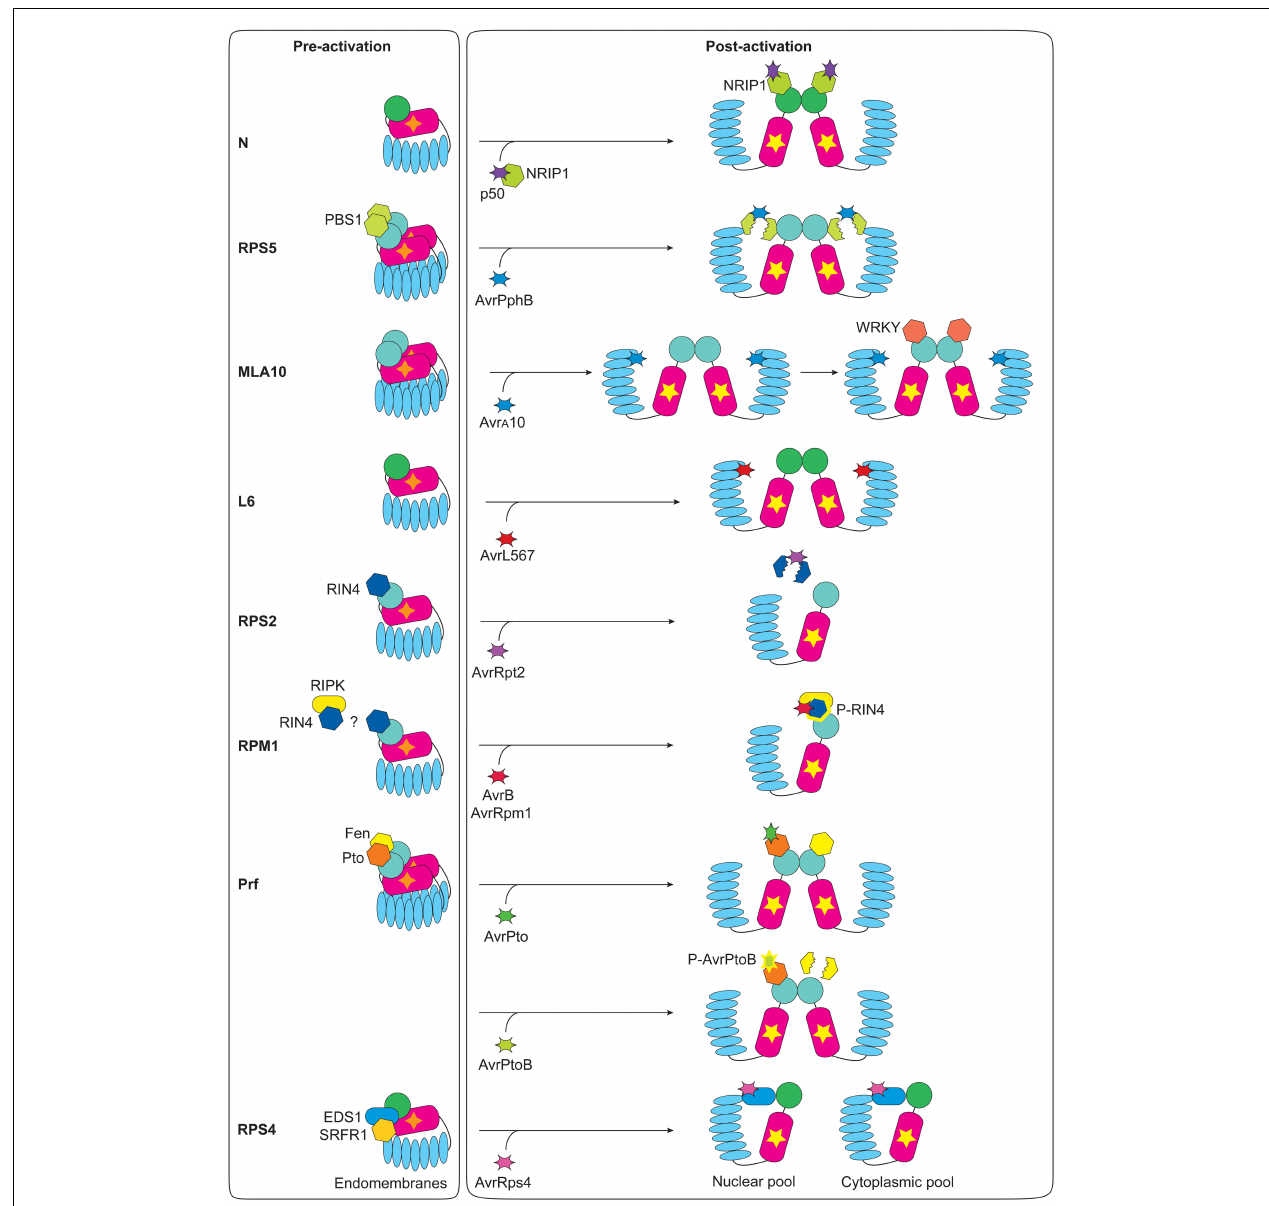
FIGURE 2 | Pre- and post-activation status of NLR immune complexes in plants. The order of the NLRs described reflects the presentation in the text. N exists as monomers prior to activation. p50 sequesters the chloroplastic protein NRIP1 and allows association of NRIP1 to theTIR domain of N, and dimerization of N. RPS5 dimerizes in its resting state and is associated with PBS1 through the RPS5 CC domain. AvrPphB targets and cleaves PBS1, activating RPS5. MLA10 exists in inactive homodimers and recognition of the specific pathogen effector triggers nucleotide-binding/hydrolysis/ exchange-dependent conformational changes that allow the recruitment of WRKY transcription factors. L6 is in an inactive monomeric state and upon AvrL567 recognition through the LRR domain, L6 self-associates into dimers throughTIR–TIR domain interactions. RPS2 associates with RIN4 prior to activation; no evidence for RPS2 homodimerization exists. AvrRpt2 targets and cleaves and this relieves RIN4-dependent suppression of RPS2 activity. Resting state RPM1 is in a heteromeric protein complex that comprises the guardee RIN4. Moreover RIN4 also associates with RIPK, but whether